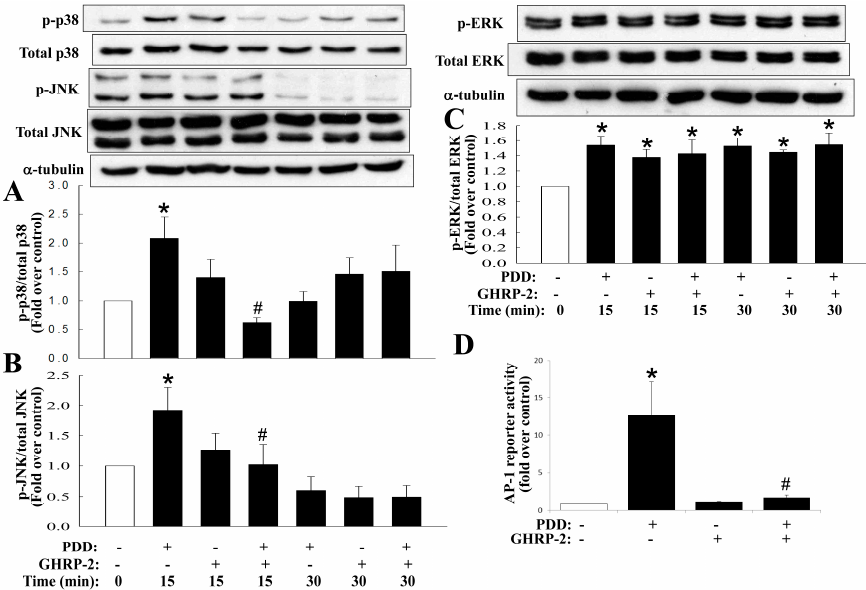
Figure 7. Attenuation of PKC-induced p38 and JNK phosphorylation and PKC-mediated activator protein 1 (AP-1) reporter activity by GHRP-2. Plated KGN cells were pretreated with GHRP-2 for 10 min and then the cells were exposed to PDD (100 nM) for 15 or 30 min. The effects of GHRP-2 on p38 ( A ); JNK ( B ); and ERK ( C ) phosphorylation were monitored by Western blotting assay. ( D ) To examine the impact of GHRP-2 on PKC-induced AP-1 reporter activation, plated KGN cells were transfected with an AP-1 reporter plasmid that controlled a luciferase reporter gene and co-transfected with pCMV- β -Gal as a control plasmid. Transfected cells were untreated, treated with either PDD (100 nM) or GHRP-2 (1 µM) alone, or treated with a combination of PDD and GHRP-2 for 12 h. The AP-1 reporter activity was determined by luciferase assay and normalized against the β -galactosidase activity from pCMV- β -Gal of the same samples. The results represent the means ± SEM (( A ): n = 5; ( B – D ): n = 4) separate experiments. * p < 0.05 compared with the control; # p < 0.05 compared with the PDD treatment.